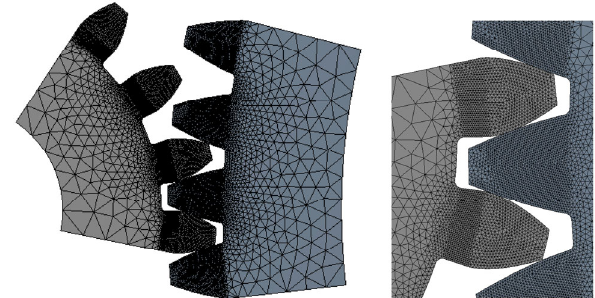
Fig. 5 Finite element model for spur